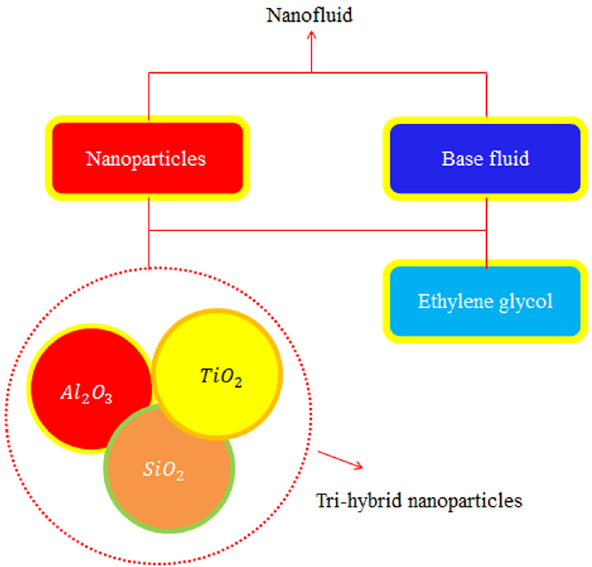
Figure 1: Prepared approach regarding mixtures of ternary hybrid